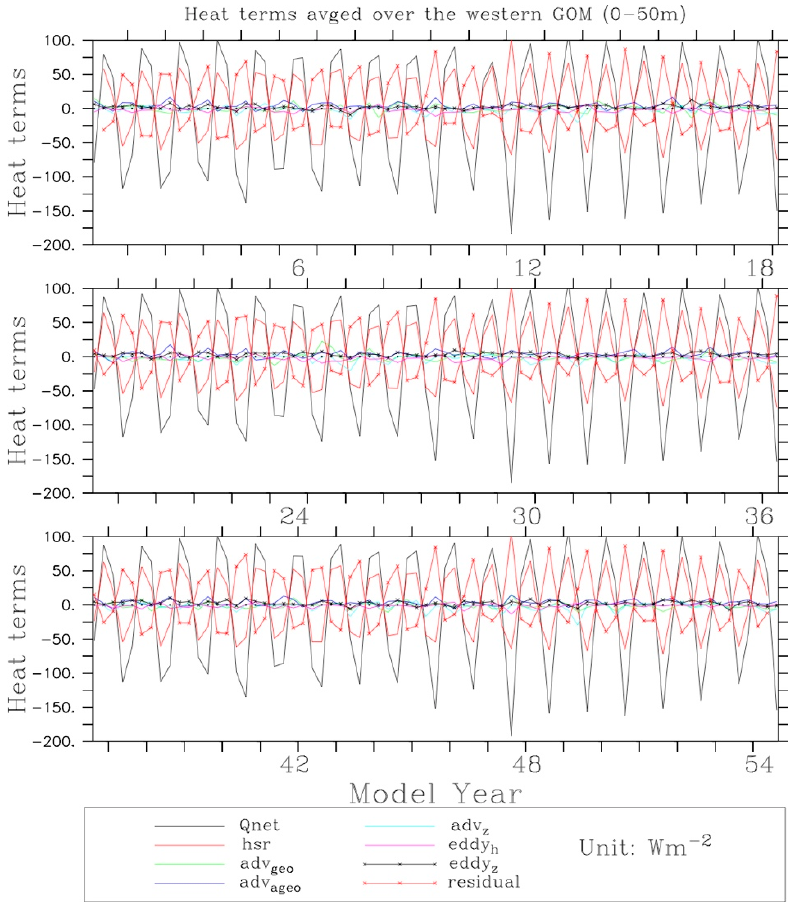
Figure 12. Same as Figure 10 except for heat terms area-averaged over the whole western